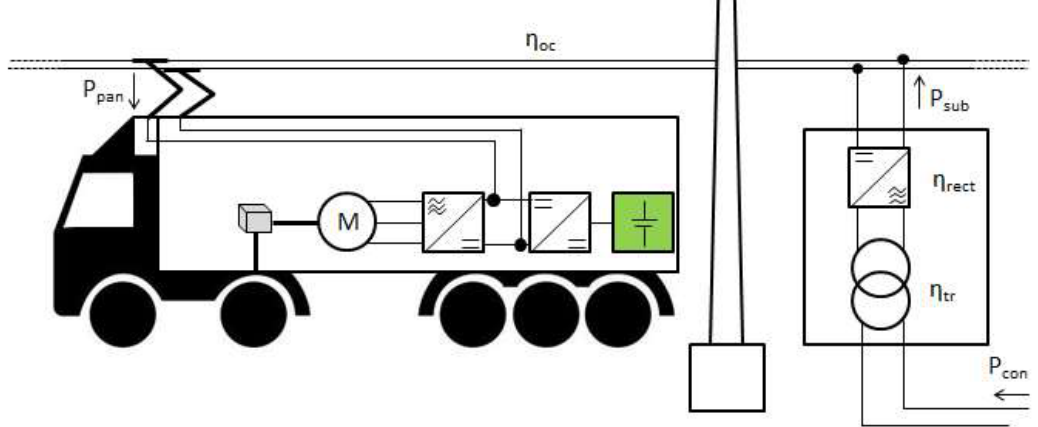
Figure 6. Scheme of a catenary power system and the drivetrain of an overhead catenary truck.